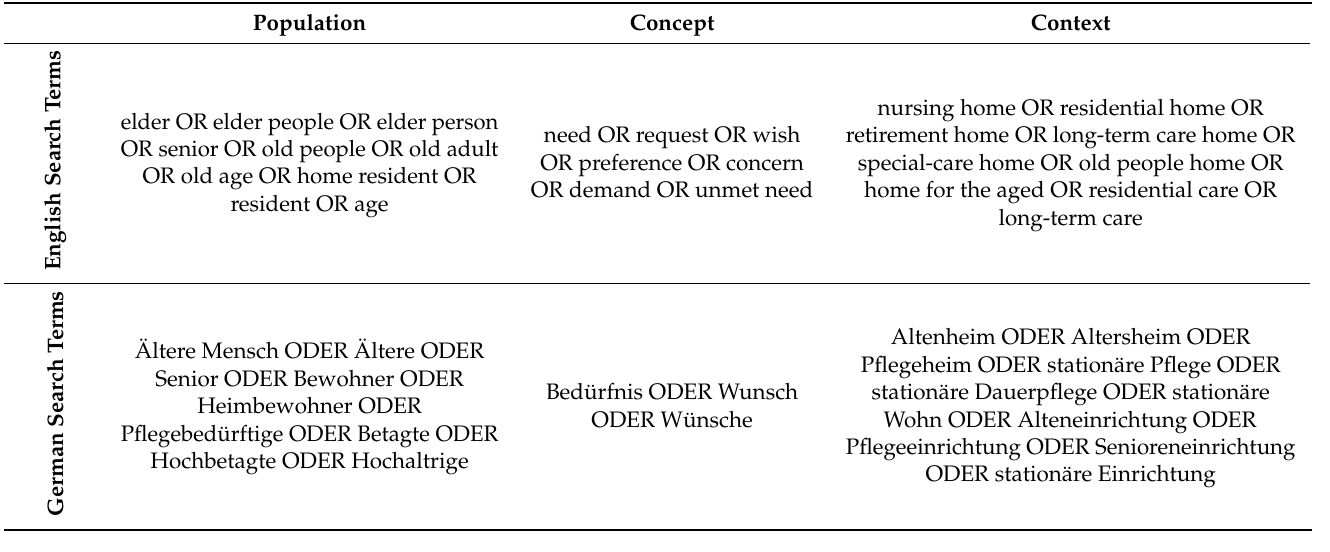
Table 1. Search Terms in English and